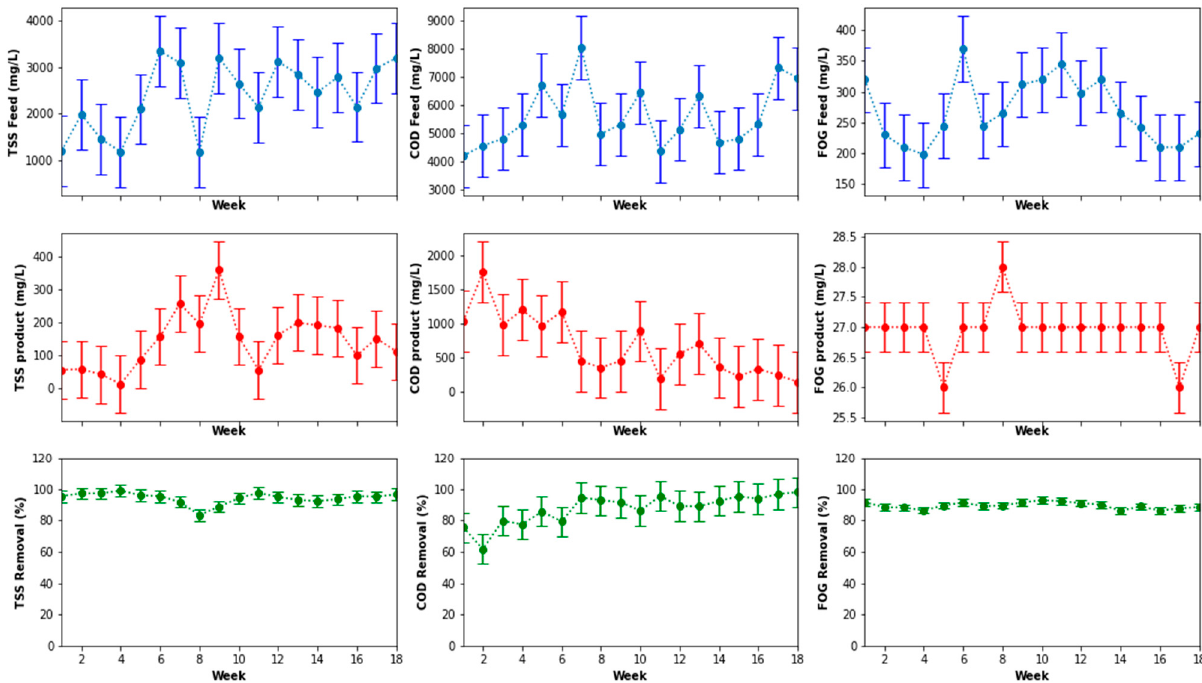
Figure 10. Performance of DEGBR after outliers replacement.